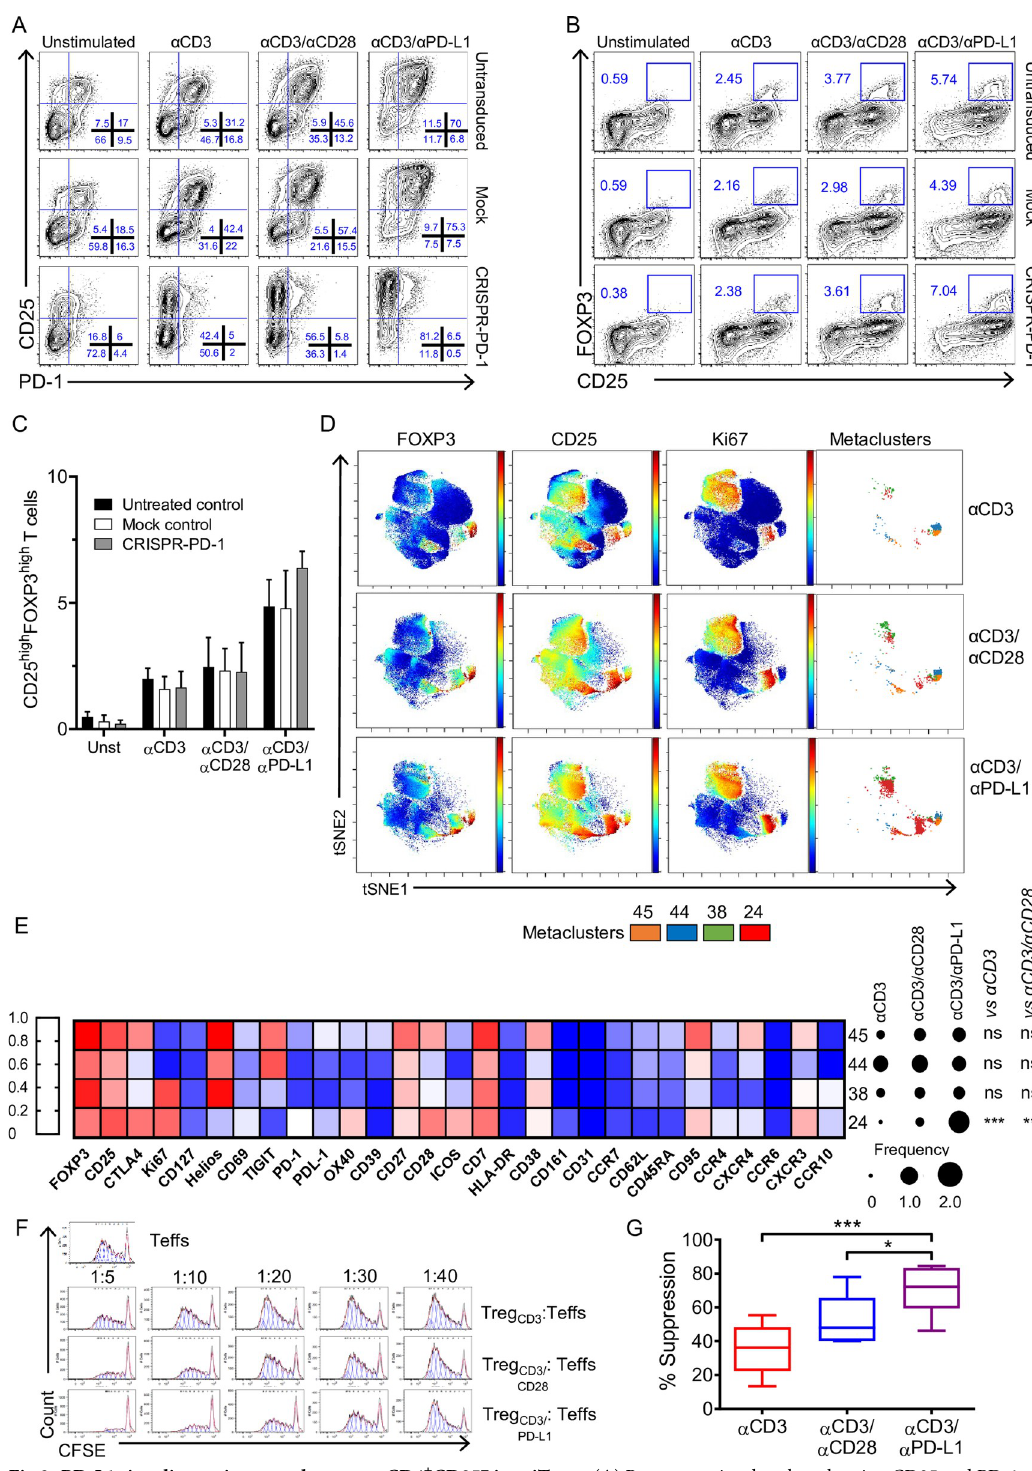
Fig 2. PD-L1 signaling activates and converts CD4 + CD25 − into iTregs. ( A ) Representative dot plots showing CD25 and PD-1 expression on untreated control, mock-treated, and CRISPR/Cas9-PD-1-edited CD4+CD25 − T cells activated for 72 h as indicated. ( B ) Representative plots showing FOXP3 and CD25 expression of untreated control, mock control, and CRISPR/ Cas9-PD-1-edited CD4 + CD25 − T cells activated for 72 h as indicated. (C) Cumulative results expressed as percentage of CD25 high FOXP3 high T cells. Data are expressed as mean ± SD and are pooled from at least 2 independent experiments ( n =